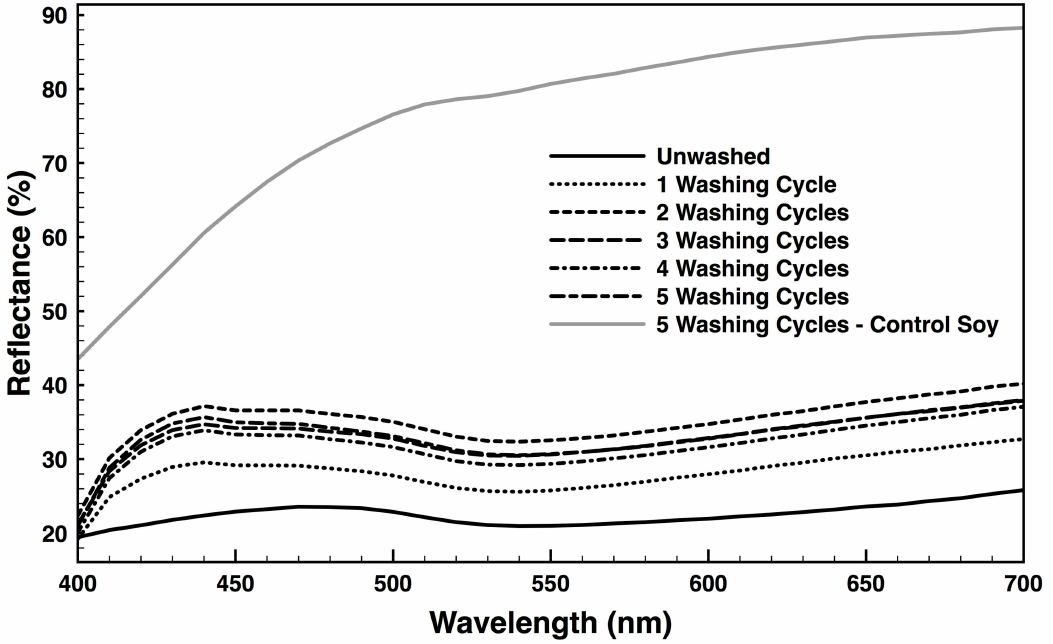
Figure 8. Reflectance of AuNPs functionalized fabrics, pre-treated with chitosan, unwashed and after 1 to 5 washing cycles, obtained in the range of 400 to 700 nm at standard illuminant D65. Table 4. Overall colour di ff erence ( ∆ E*) and shift of the coordinates of the colour in the cylindrical colour space, lightness (L*), red-green (a*), and yellow-blue (b*), of AuNPs functionalized fabrics, pre-treated with chitosan, before and after washing cycles (unwashed, 1, 2, 3, 4 and 5).